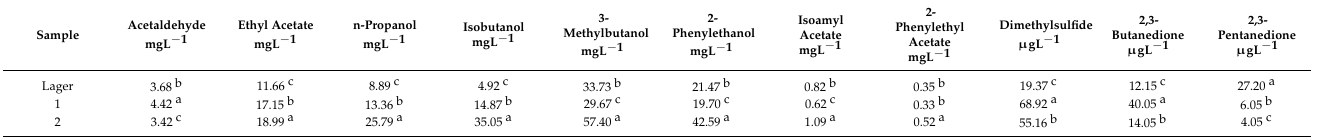
Table 4. Results of GC-MS analysis of beer samples used for sensory